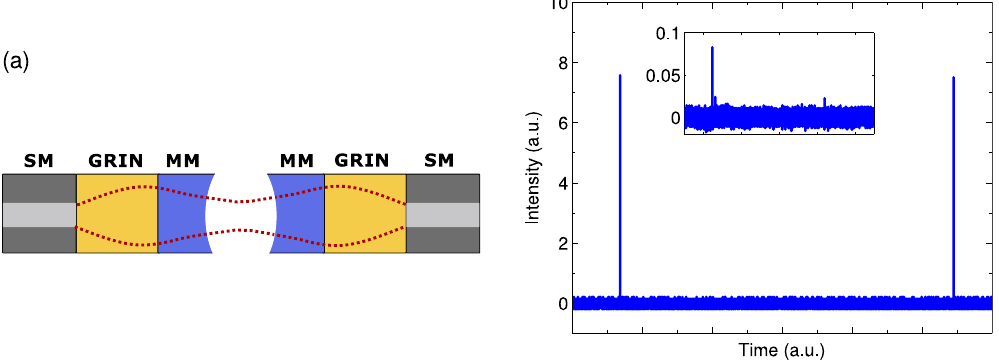
Figure 5. ( a ) Schematic of a FA-FA system where mode matching fiber assemblies are used as the input as well as the output of the FFPC. ( b ) Transmission spectrum of the FA-FA system as the cavity is scanned by a piezo actuator over approximately one FSR. The inset shows details of the higher order mode